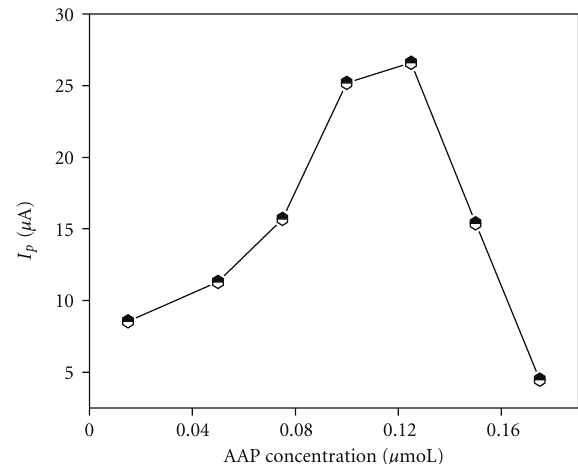
Figure 3: E ff ects of deposition time on DPV peak currents for 5 × 10 − 7 molL − 1 Hg 2+ at AAP modified GCE. E conditions are the same as in Figure 2.